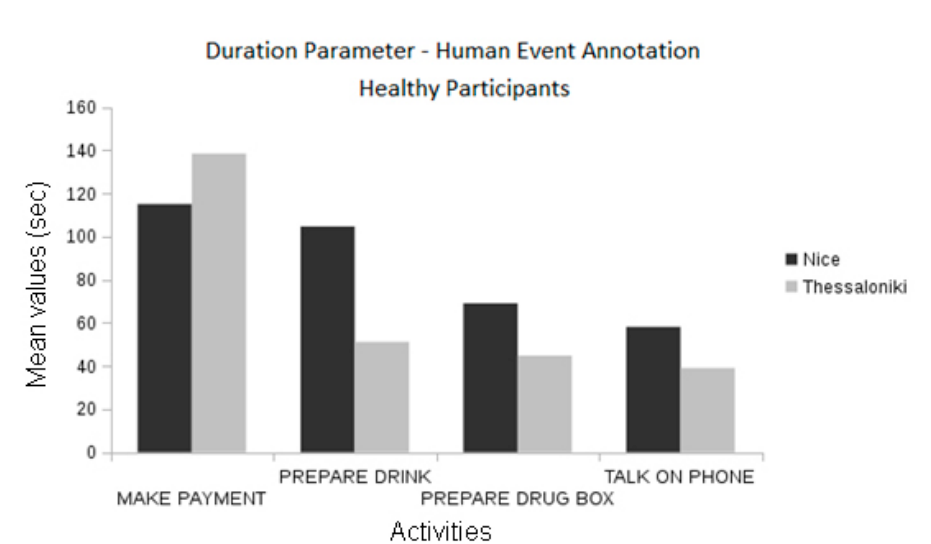
Figure 12. Comparison between the pilots concerning the event duration using the manually annotated data.